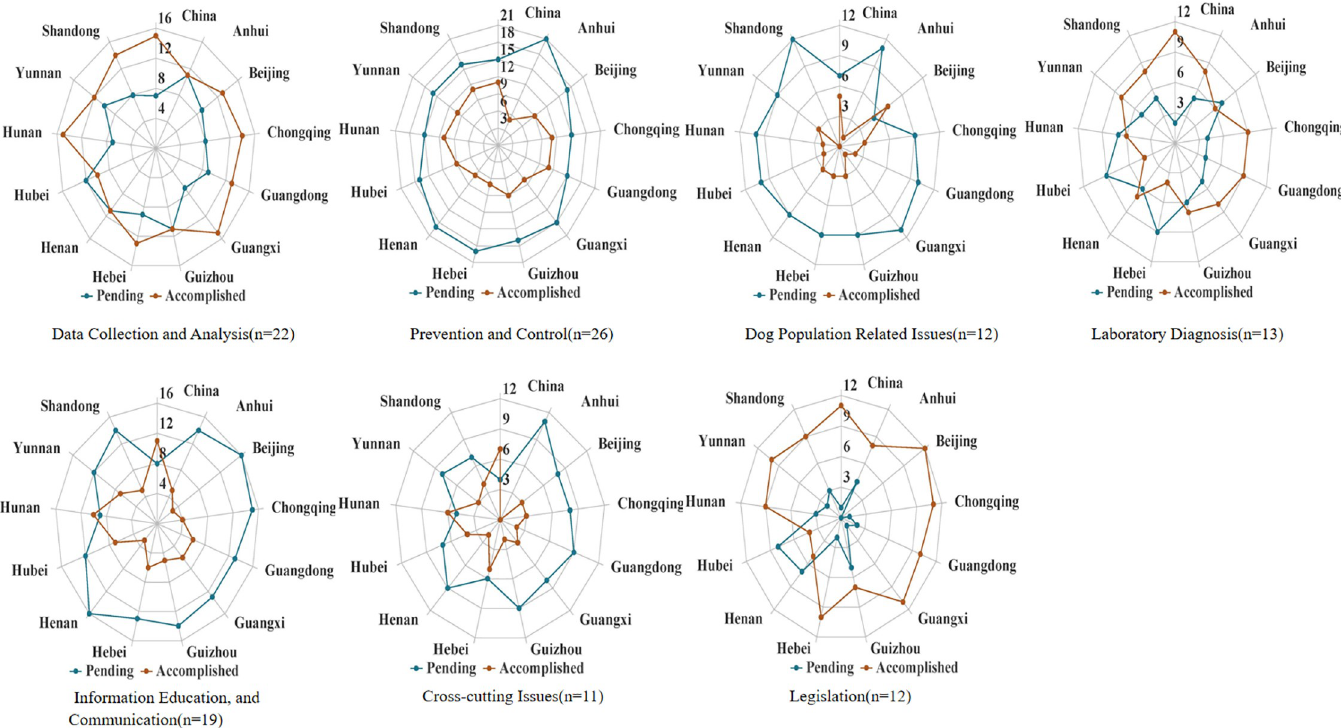
Fig 2. Summary of results for the National Rabies Program and for 12 Provincial level Programs, by the seven categories outlined in the SARE assessment tool, China, March 2019. (Note: For each category, the number of pending and accomplished activities are presented. SARE referred to Stepwise Approach towards Rabies